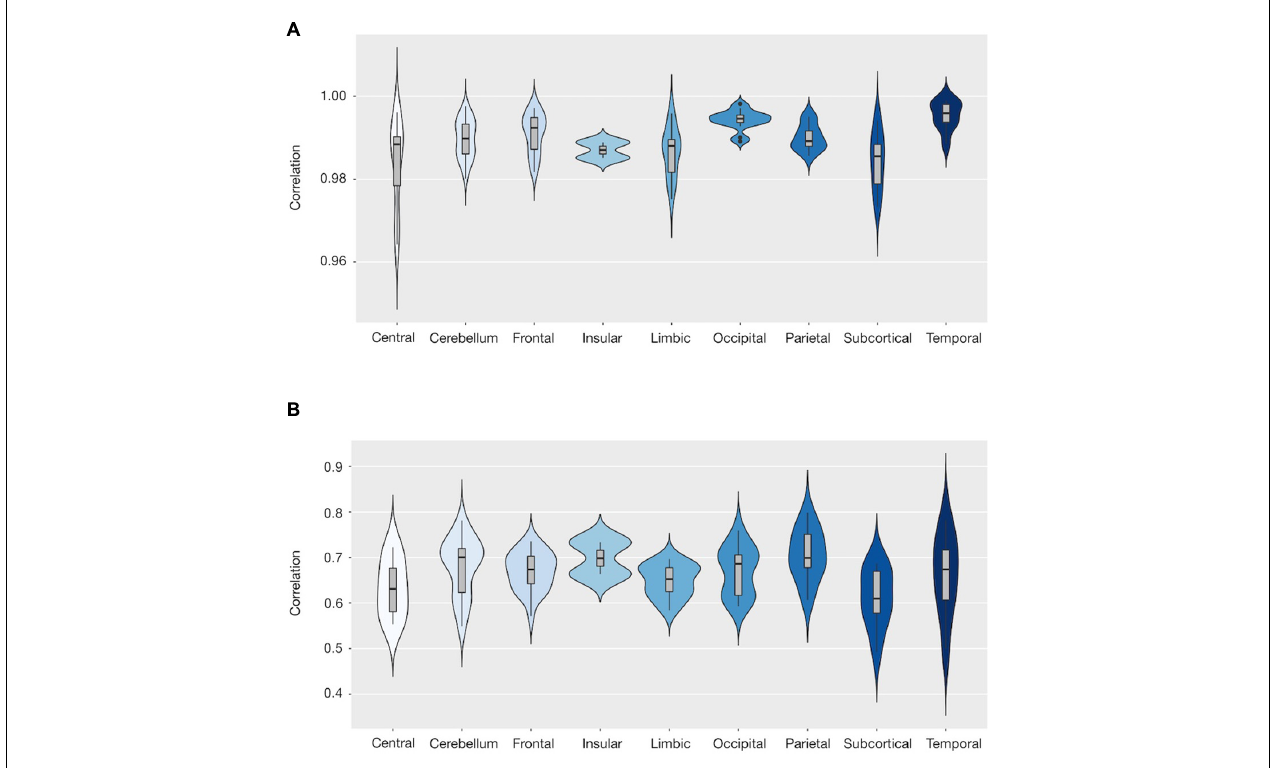
FIGURE 4 | Violin plot showing the distribution of the correlations between the actual and estimated volumes by region within each lobe. We present two results: from combining deep learning and frequency features (A) , and from frequency features solely (B) . The X-axis shows the lobe defined according to the automated anatomical labeling (AAL) atlas, whereas the Y-axis shows the correlation coefficients for each lobe. The broader sections of the violin plot represent a higher probability, whereas the thinner sections represent a lower probability. The thick black bar in the center represents the interquartile range, whereas the thin black line represents 1.5 times the interquartile